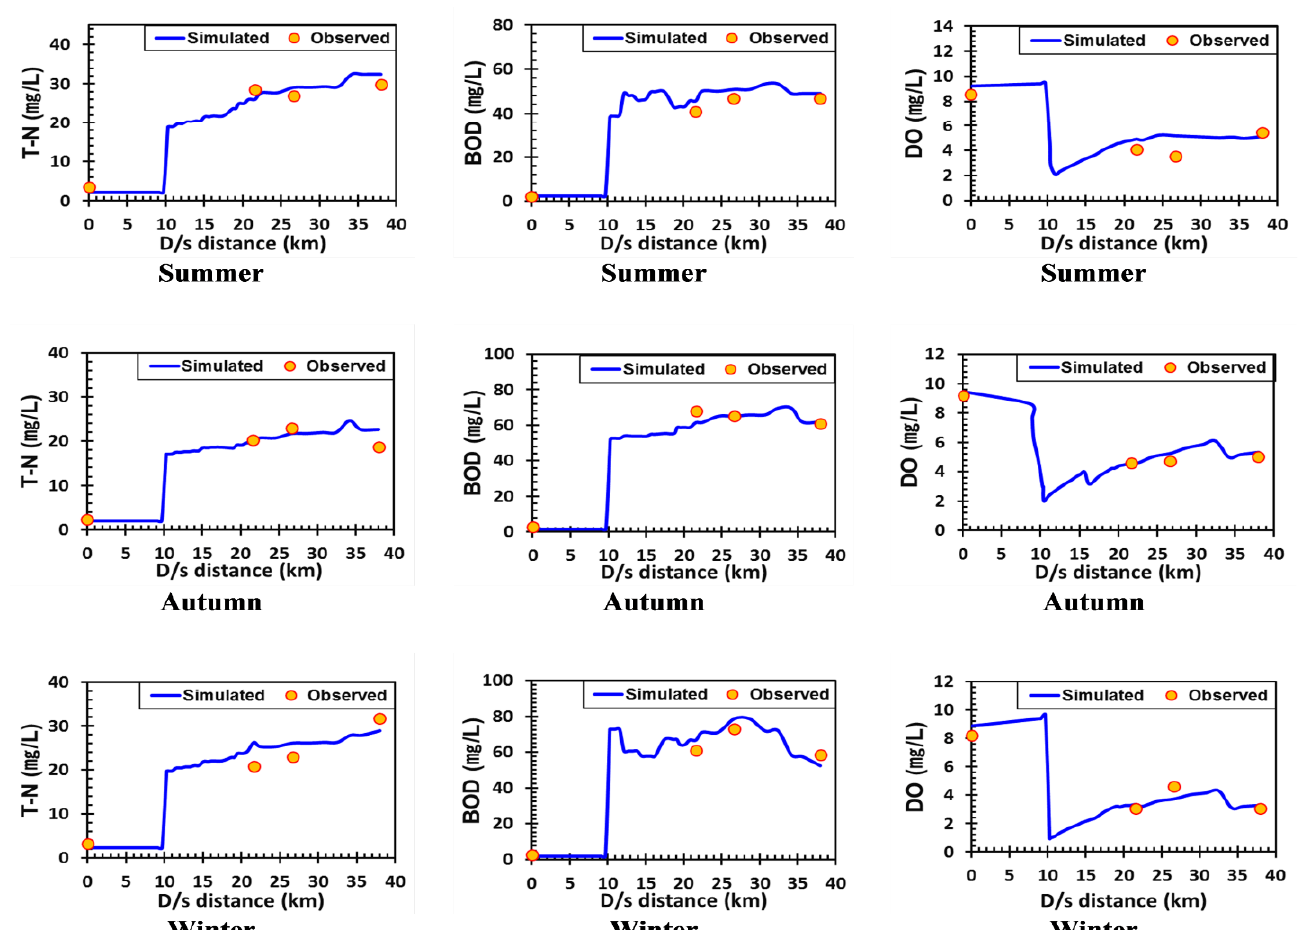
Figure 6. Confirmation of water qualities in the Yamuna Waterway for summer, autumn, and winter seasons.